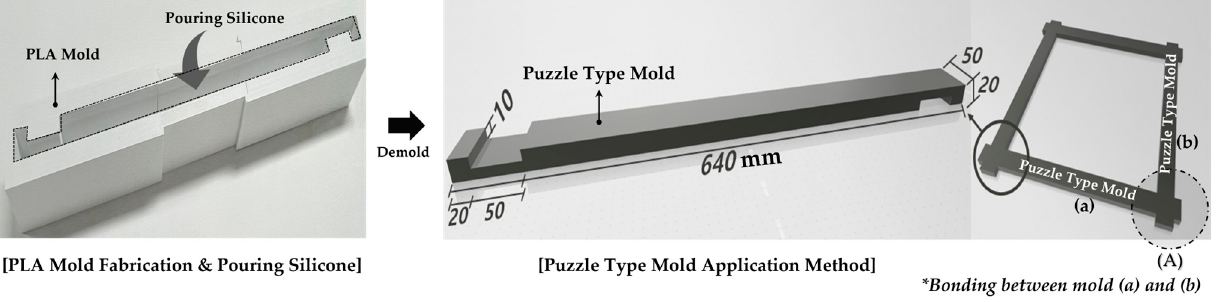
Figure 3. Puzzle-Type Mold.